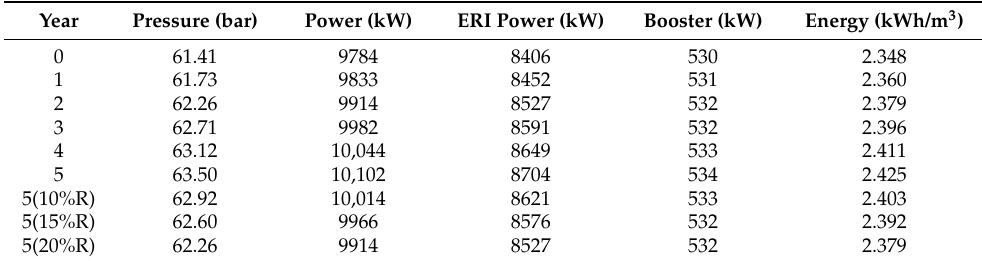
Table 11. Pressure, Power, and Energy consumption at 17 ◦ C.